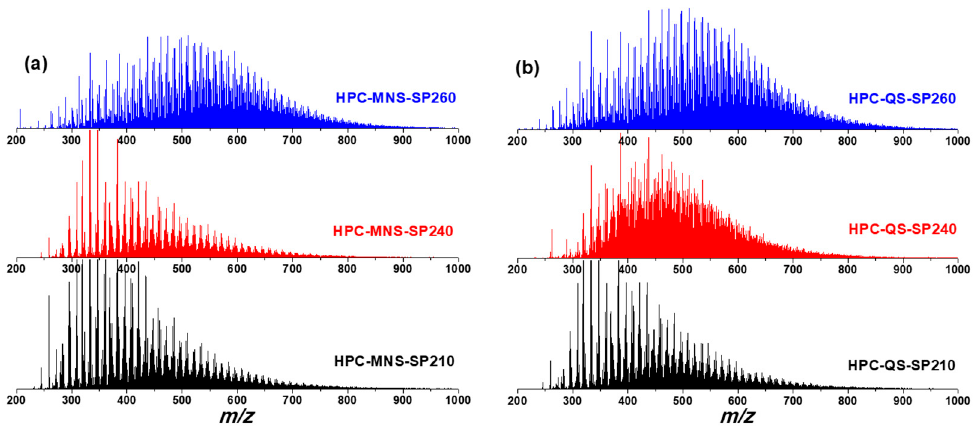
Figure 6. Molecular weight distribution of HPC-MNS ( a ) and HPC-QS ( b ) derived pitches.